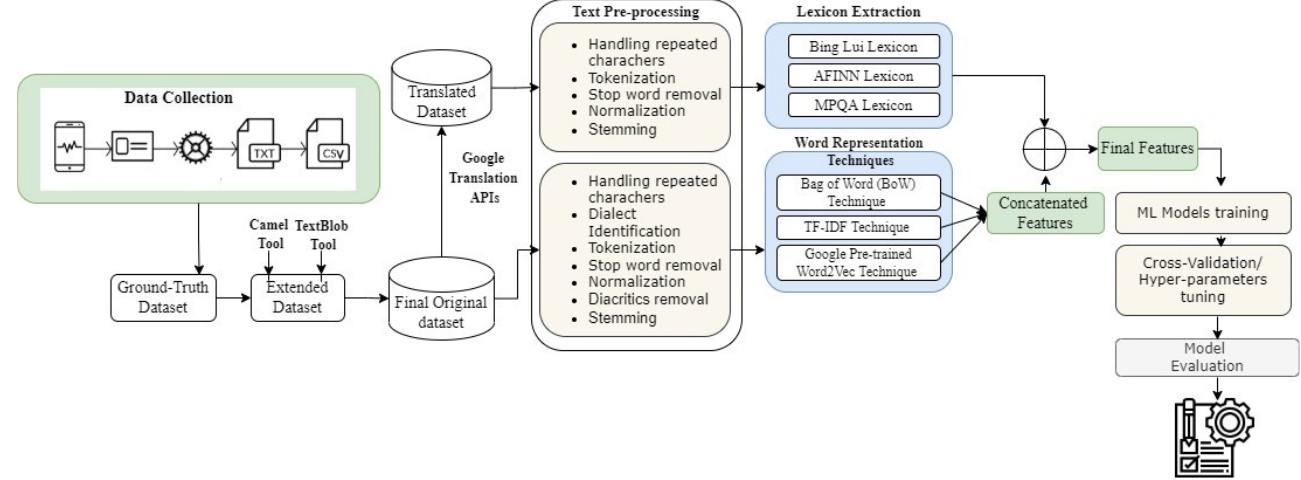
Figure 1. The study’s overall framework.